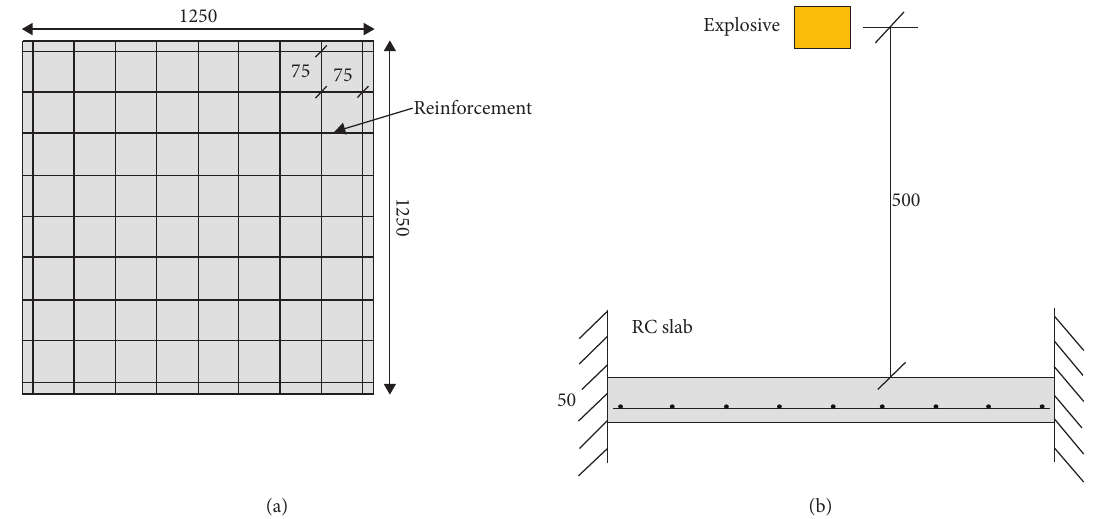
Figure 1: Dimension of the RC slab (unit: mm): (a) sectional view and (b) cross-sectional view.